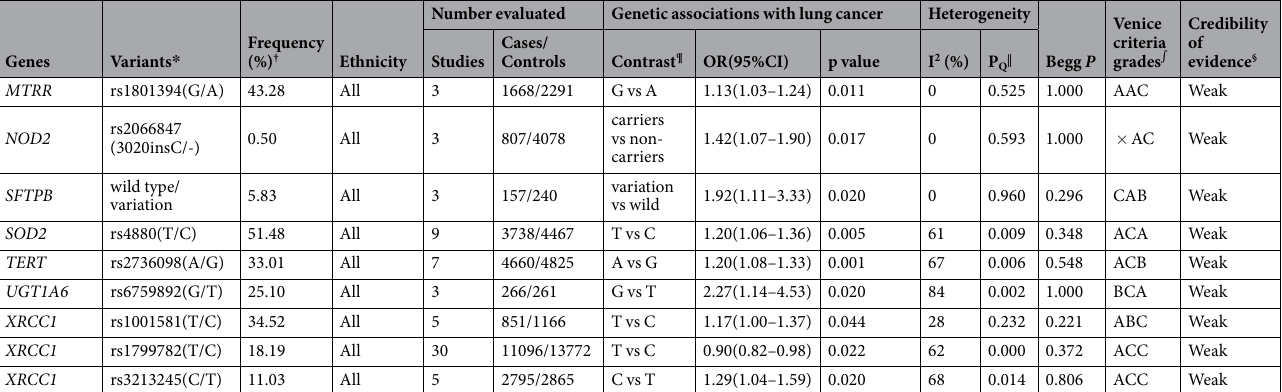
Table 1. Genetic variants with significant associations with lung cancer risk in main meta-analyses (Continued on next page) OR = odds ratio; 95% CI = 95% confidence interval. VNTR = variable number of tandem repeats. CNV = copy number variation. ins = insertion. * Minor alleles/major alleles (per Caucasian); majors alleles were treated as reference alleles in the analyses. † Frequency of minor allele or effect genotype (s) in controls in main meta-analyses. ¶ Allelic contrast or phenotype trait for common variants; genetic comparison for rare variants or variants only with genotype group data. ǁ P value of the test for between-study heterogeneity. ∫ Venice criteria grades are for amount of evidence, replication of the association, and protection from bias; one rare variant was not scored for amount of evidence ( × ). § Credibility of evidence is categorized as “strong”, “moderate”, or “weak” for association with lung cancer risk. ‡ Only Asian or Caucasian data were available for